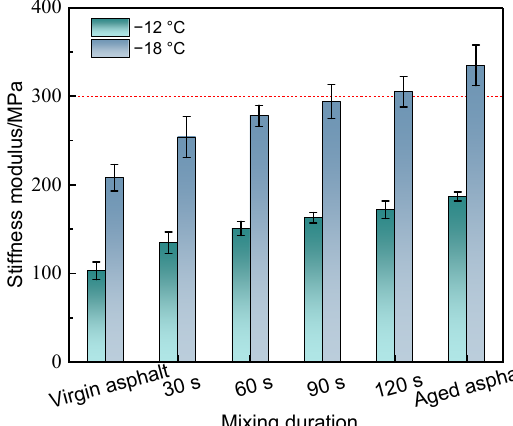
Figure 9. Variation in asphalt stiffness modulus S with different mixing durations at different temperatures.